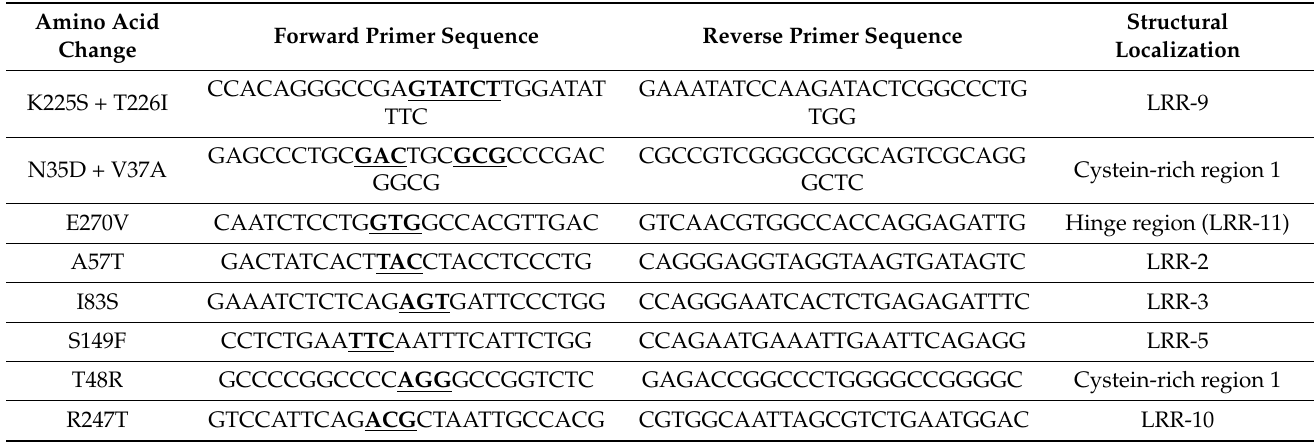
Table 5. Murinizing mutations introduced in the human LHCGR. Nucleotides inducing the amino acid changes are indicated in bold and